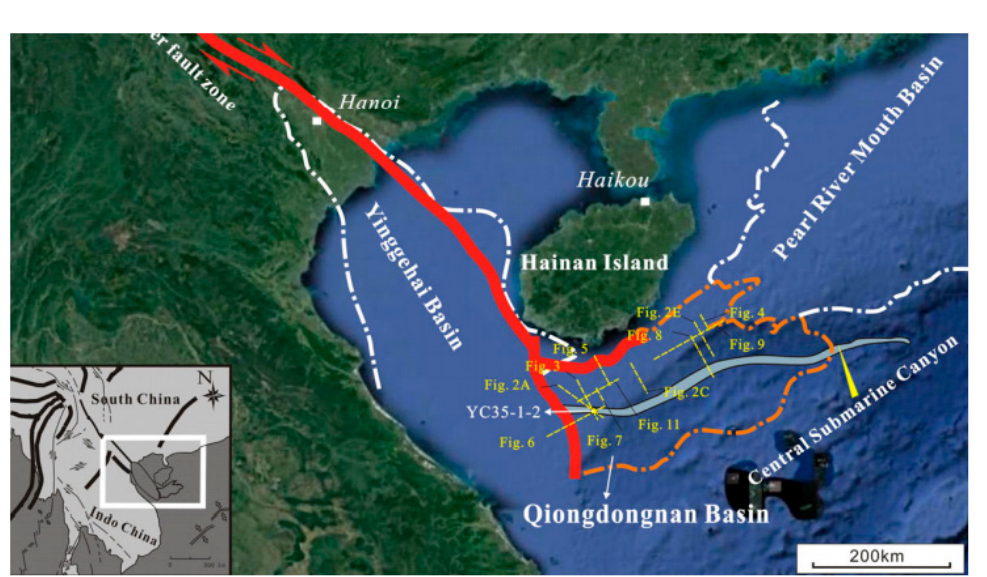
Figure 5. Location of Qiongdongnan basin. Reproduced with permission from [157].